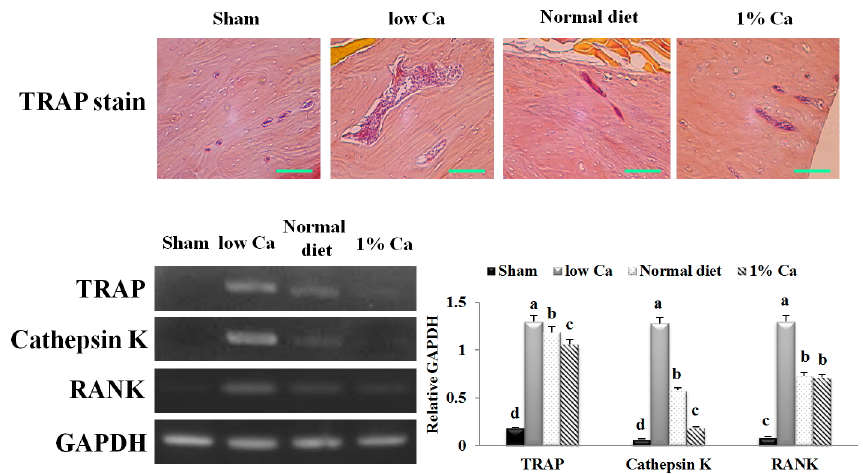
Figure 6. Tartrate-resistant acid phosphatase (TRAP) staining (scale bar: 40 μ m) and mRNA expression of TRAP, cathepsin K and receptor activator of nuclear factor kappa B (RANK) in sham, low Ca, normal diet and 1% Ca groups. Results are expressed as the means ± standard deviation (SD). Values not sharing a common superscript ( a , b , c , and d ) differed significantly (Duncan’s multiple range test).